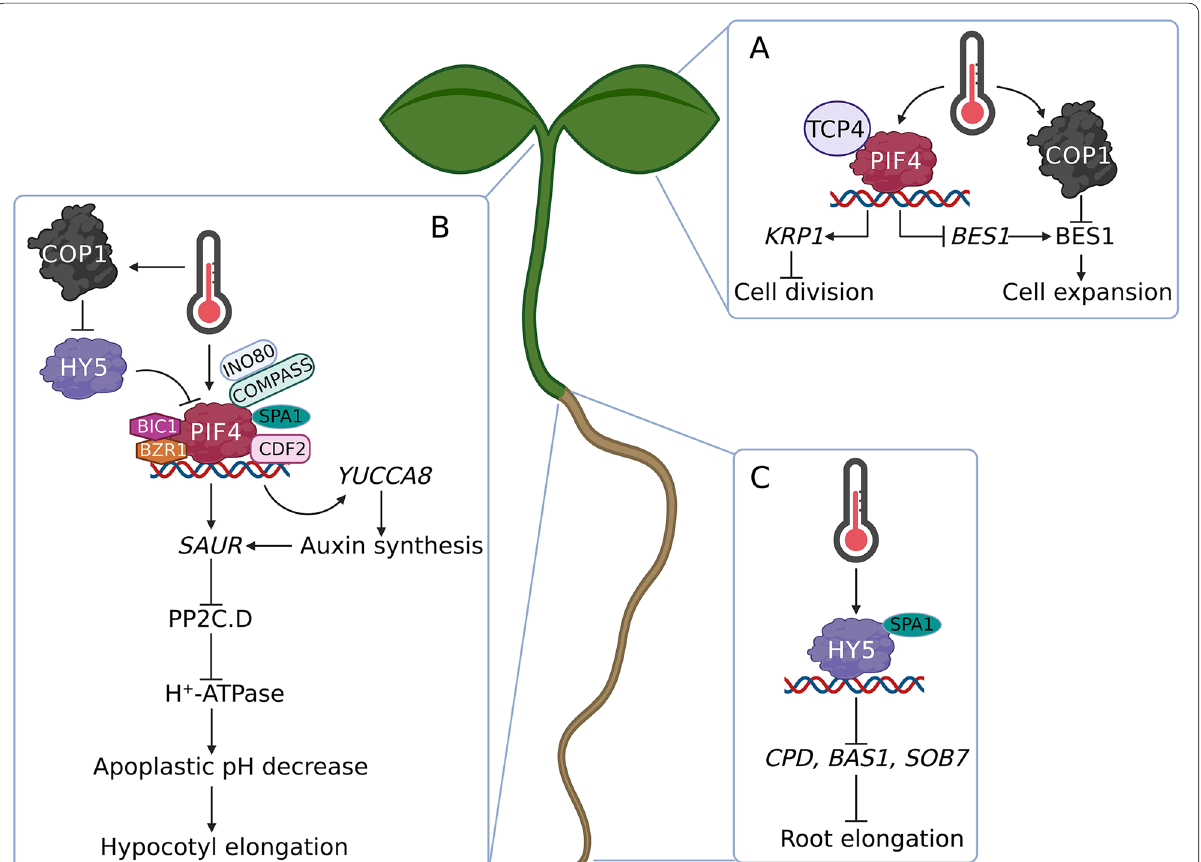
Fig. 1 High ambient temperature inhibits plant leaf expansion and promotes cell elongation in both hypocotyl and root. A In the leaves, high temperature activated transcription factor PIF4 interacts with TCP4. The TCP4-PIF4 module binds to KRP1 promoter and induces KRP1 expression to inhibit cell division. BES1 is a positive regulator for cell expansion. PIF4 directly represses BES1 transcription. On another side, high temperature increases COP1 nuclear abundances to directly target BES1 protein for degradation. These mechanisms act together to restrict leaf expansion under high ambient temperature. B PIF4 plays central roles in the high temperature induced hypocotyl elongation. PIF4 directly binds to the promoter of YUCCA8 to induce YUCCA8 expression for boosting auxin biosynthesis. The accumulated auxin further promotes the expression of SAURs . PIF4 is also able to induce SAUR transcription directly. SAUR proteins interact with PP2C.D enzymes and inhibit their enzymatic activities. The inactivation of PP2C.D further releases their repression on H + -ATPase to trigger proton transport into the apoplast. The reduction of apoplastic pH results in cell elongation due to the cell wall loosen and water uptake increase. A lot of co-factors (depicted as INO80-COMPASS, BIC1-BZR1) interact with PIF4 to enhance its transcriptional activities. SPA1 phosphorylates PIF4 to control PIF4 protein stability. The binding of PIF4 with DNA will facilitate other transcription factor (like CDF2) binding to DNA as well. High temperature also stimulates COP1 nucleus localization and enhances HY5 protein turn over. HY5 not only directly represses PIF4 transcription but also interacts with PIF4 protein to abrogate its transcriptional activity. The removal of HY5 results in the activation of PIF4. C High temperature triggers HY5 protein accumulation in roots, which directly controls the expression of brassinosteroid (BR) metabolism genes ( CPD , BAS1 and SOB7 ) and root cell elongation. SPA1 also regulates HY5 protein phosphorylation and